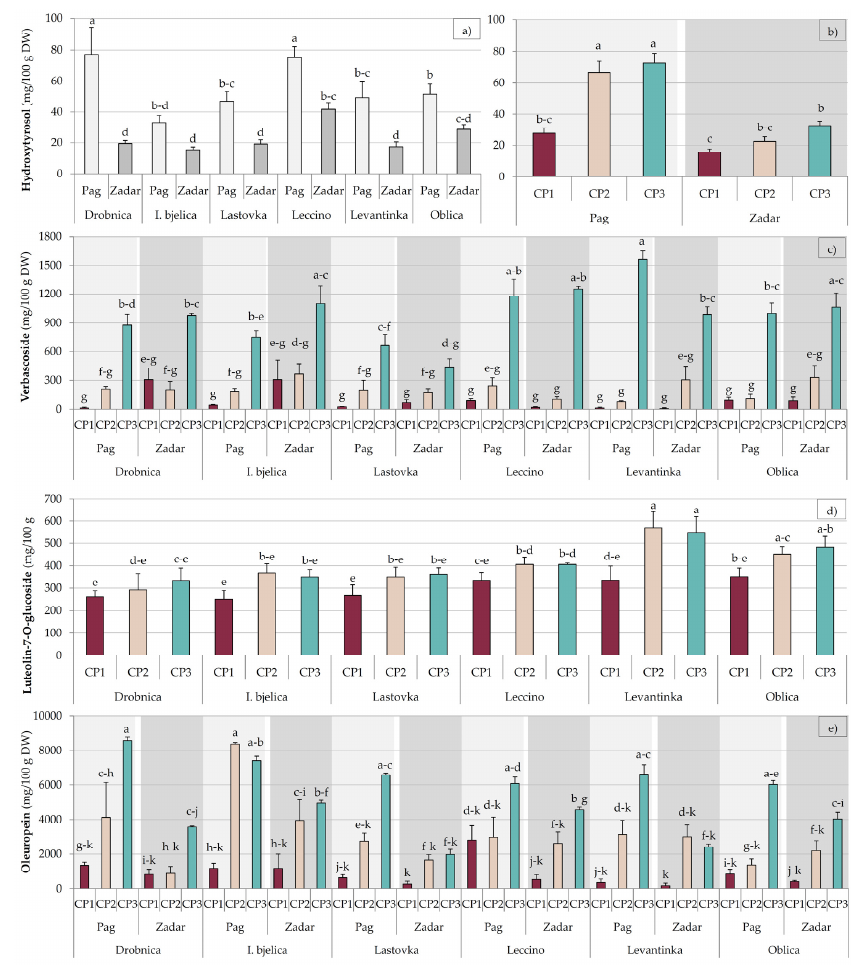
Figure 1. Multiple comparisons of the e ff ects of cultivar, collection period, and location combinations (highest order interactions) on the concentrations of ( a , b ) hydroxytyrosol, ( c ) verbascoside, ( d ) luteolin-7- O -glucoside, and ( e ) oleuropein in leaves of Drobnica, Istarska bjelica (I. bjelica), Lastovka, Leccino, Levantinka, and Oblica olive cultivars collected at different periods (CP1—October 2017, CP2—January 2018, and CP3—March 2018) in two different locations (Pag and Zadar) in Croatia (burgundy, beige, and turquoise colors of histogram bars represent collecting periods CP1, CP2, and CP3, respectively, while lighter and darker gray colors (histogram bars and backgrounds) represent Pag and Zadar locations, respectively). Different superscript lowercase letters represent statistically significant differences between mean values at p < 0.05 obtained by a one-way ANOVA and Tukey’s test.